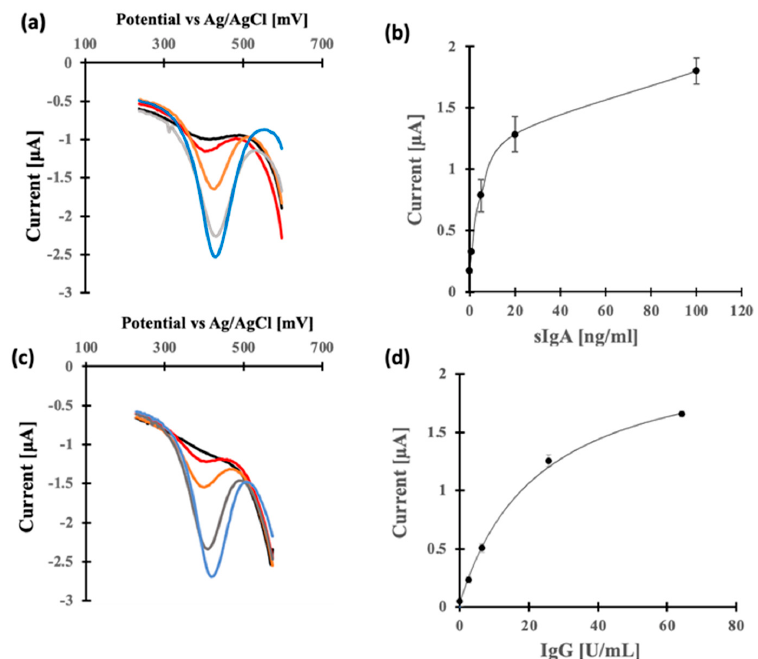
Figure 1. Current-potential profiles ( a , c ) and calibration curves ( b , d ) of neutralizing antibodies sIgA and IgG were obtained using the GLEIA − based electrochemical immunosensor. Current − potential responses were tested under different concentrations of ( a ) sIgA 100 ng/mL (blue), 20 ng/mL (grey), 5 ng/mL (orange), 1 ng/mL (red), and 0 ng/mL (black) and ( c ) IgG 62.5 U/mL (blue), 25 U/mL (grey), 6.25 U/mL (orange), 2.5 U/mL (red), and 0 U/mL (black). Calibration curves were indicated for sIgA ( b ) and IgG ( d ) as Michaelis–Menten-type functions by a non-linear curve fitted in the graphing software Origin2022 (OriginLab).